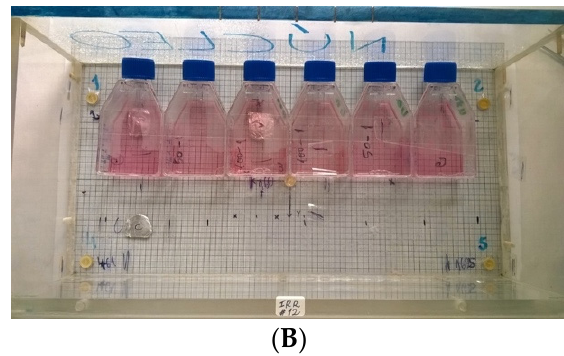
Figure 1 . ( A ) Cut view of the thermal column. The core is represented in red. The source file of the core model was applied on the purple line. ( B ) The irradiation box used to expose the cells.